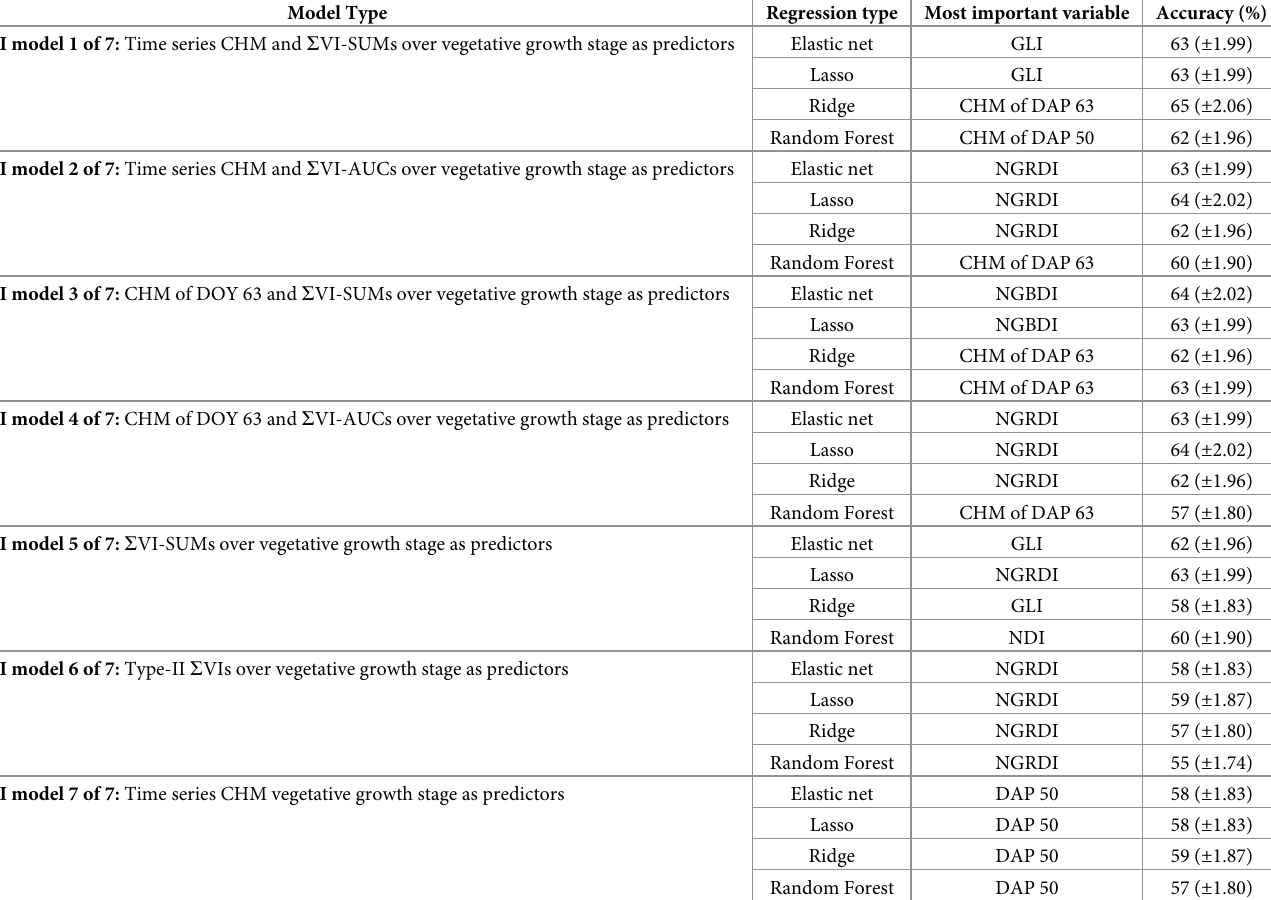
Table 3. Results of Group-II models. The results include results from regression types for each model (column 2), and both most important variables for each model for each regression type (column 3), and accuracies of each model for each regression type (column